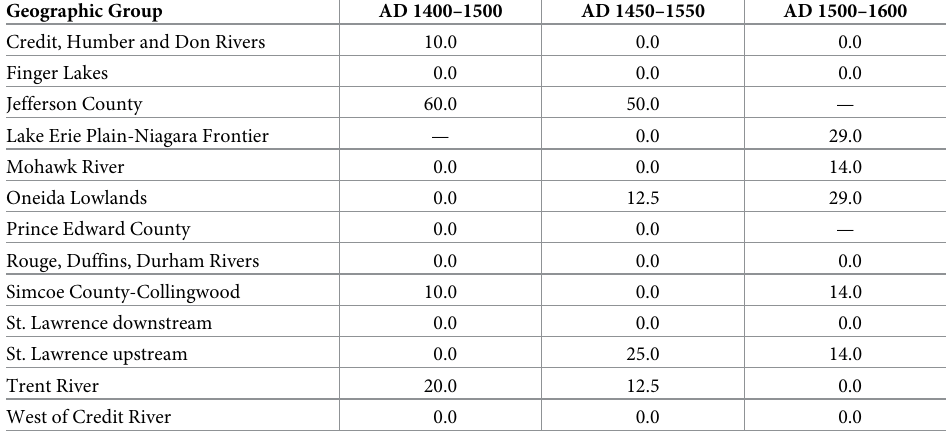
Table 3. Percentage of individual sites in the 90 th -percentile of potential brokerage scores [14] by geographic clus- ter for weighted 100-year graphs. Geographic